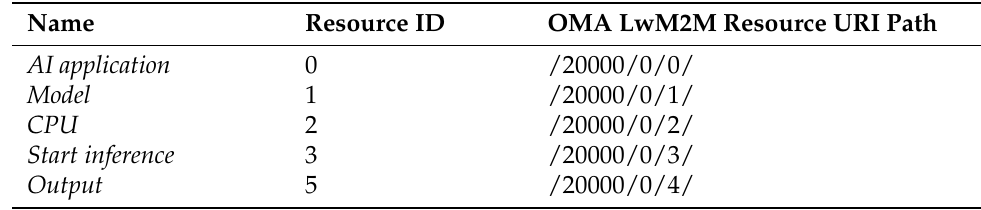
Table 3. OMA-TinyML object